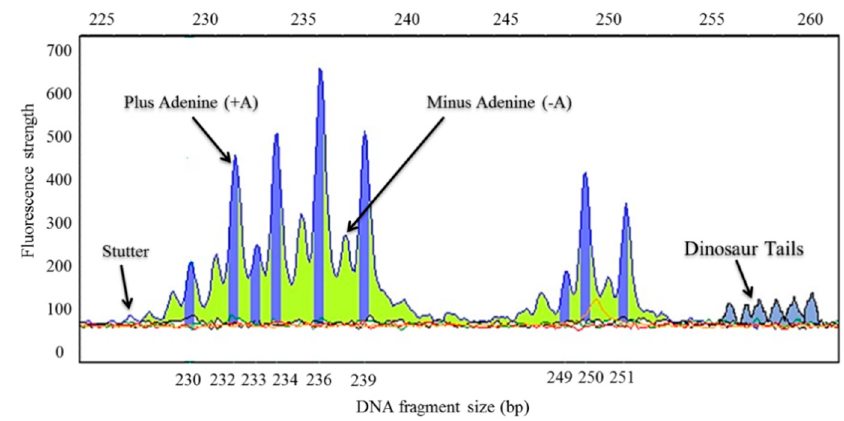
Figure 2. Several types of irregular and true peaks found in capillary electrophoregrams of sugarcane microsatellite DNA products: “Minus Adenine ( − A)” low strength peaks (indicated by green colors) differ from “Plus-A” peaks by a single adenine nucleotide and can be omitted during scoring, followed by “Plus Adenine (+A)”, the blue peaks, which represent true peaks and can be picked up. “Stutters” are peaks less than 1/3 of the height of the regular peaks that are larger in size by a single repeat unit; “Dinosaur tails” appear as one or several arrays of very low height peaks in a higher molecular weight zone. The Y-axis shows the fluorescence strength or yield of the amplified DNA fragment. The X-axis represents base pair sizes of DNA fragments.